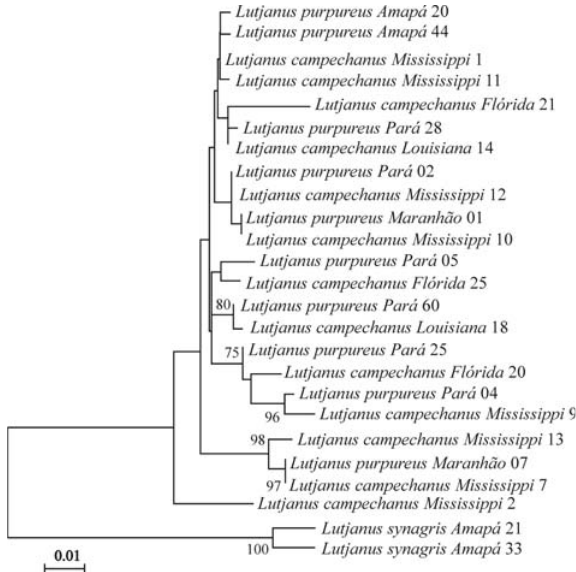
Figure1 -Neighborjoiningtreeof L.purpureus and L.campechanus pop - ulations from the West Atlantic based on the control region of mitochon- drial DNA. Numbers in the branches are bootstrap values obtained with 1000 pseudoreplicates. Bootstrap values shown in the tree are = 75%. The